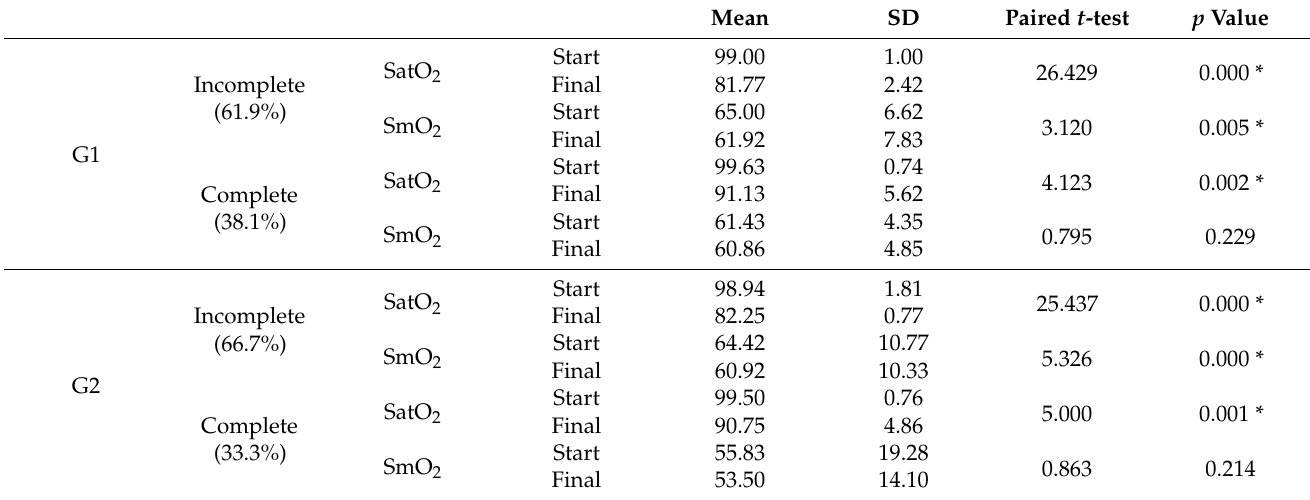
Table 4. Differences in SatO 2 and SmO 2 in the first test separated by subgroup and